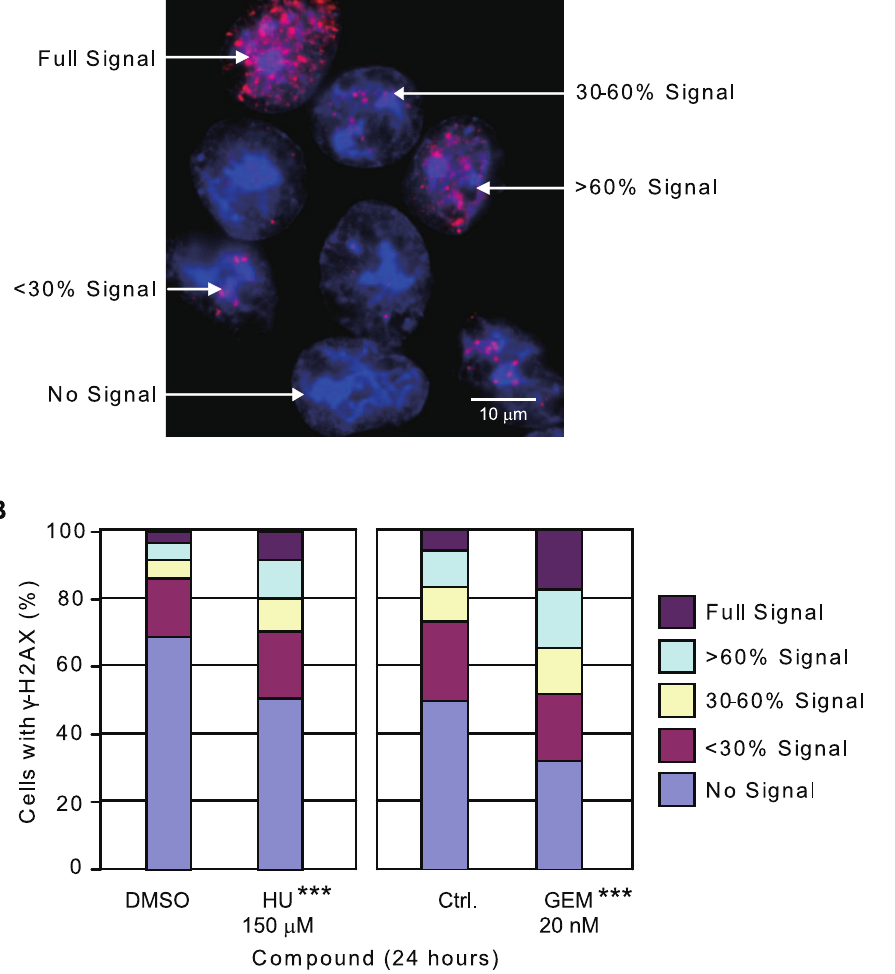
Figure 5. Induction of c -H2AX foci by HU and GEM in the UACC-1598 ovarian cancer cell line. A. Representative picture of c -H2AX foci detected by immunofluorescence and examples of how cells are grouped into different categories based on the degree of DNA damage. DAPI stained DNA is shown in blue and immunofluorescence of c -H2AX foci is shown in red. B. Percentage of cells in each category based on amount of c - H2AX foci. The statistical analysis showed the differences of cells in the No signal group vs. all other groups compared to the control cells. ***denotes a P value of , 0.001.